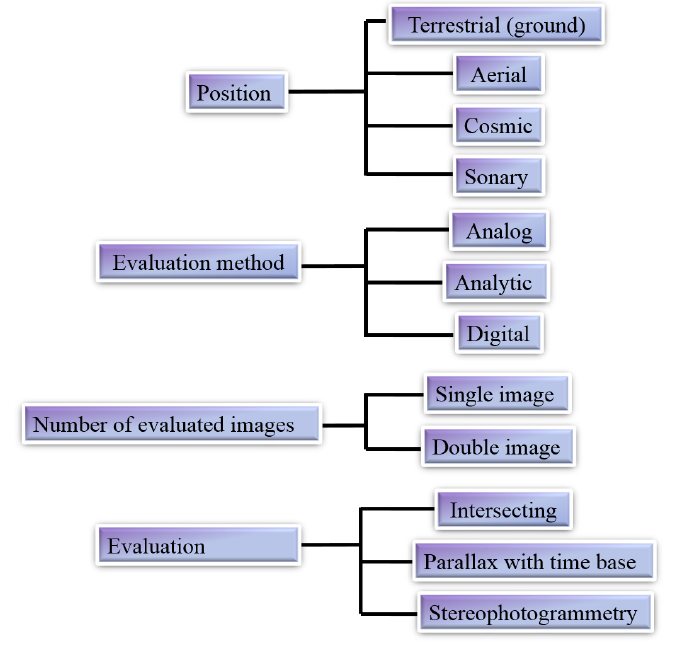
Figure 6. Scheme of photogrammetry organizations.